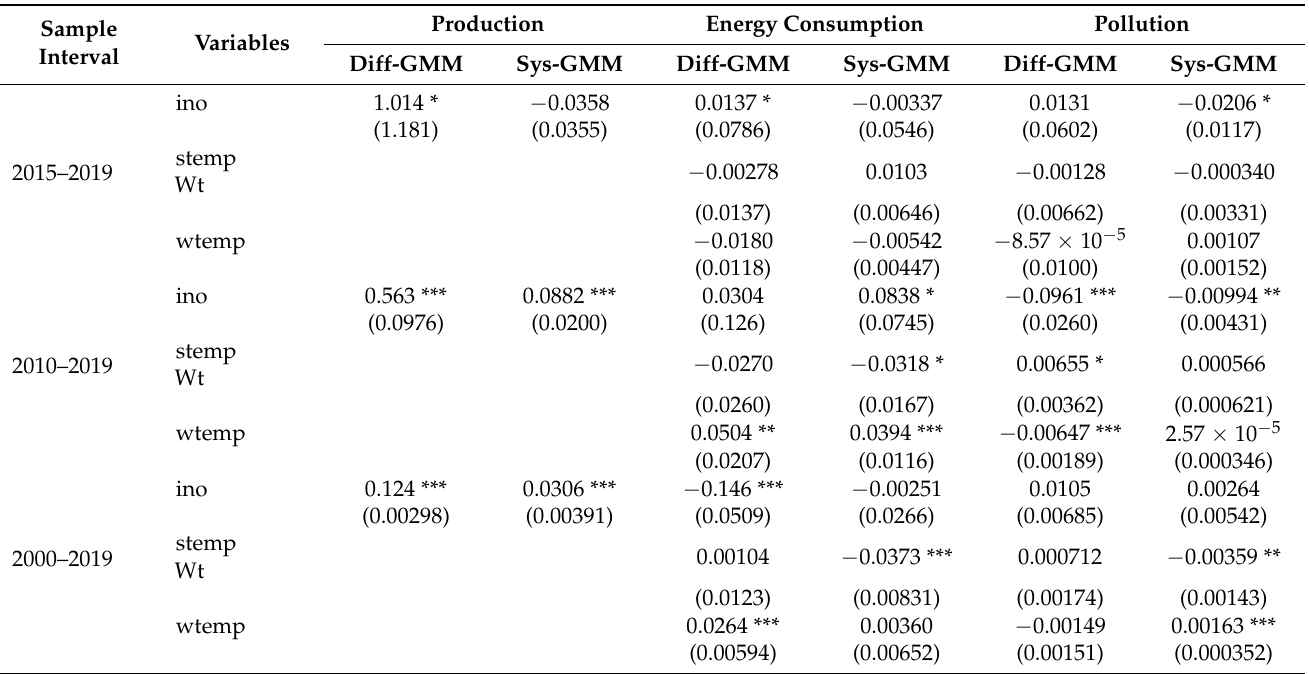
Table 11. Differences of sample interval